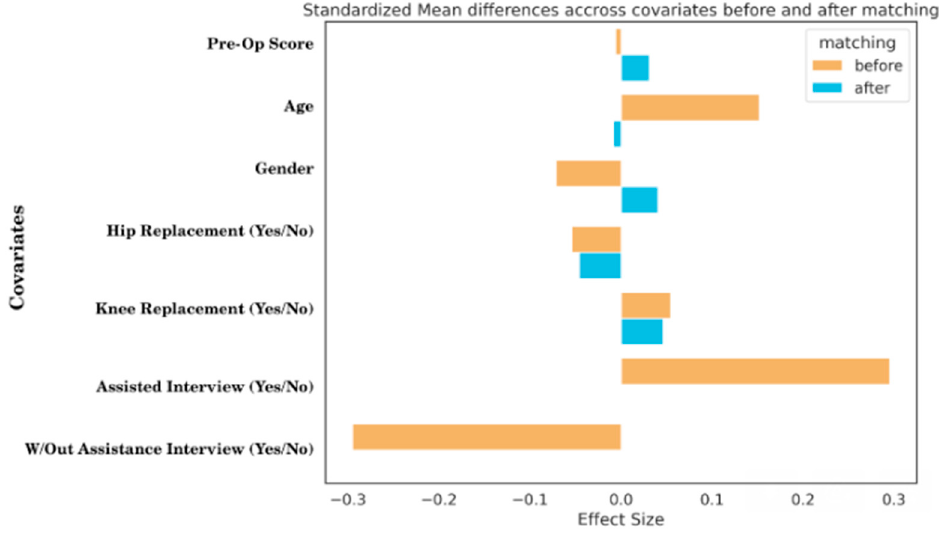
Figure 2. The effect size of the possible confounding covariates.